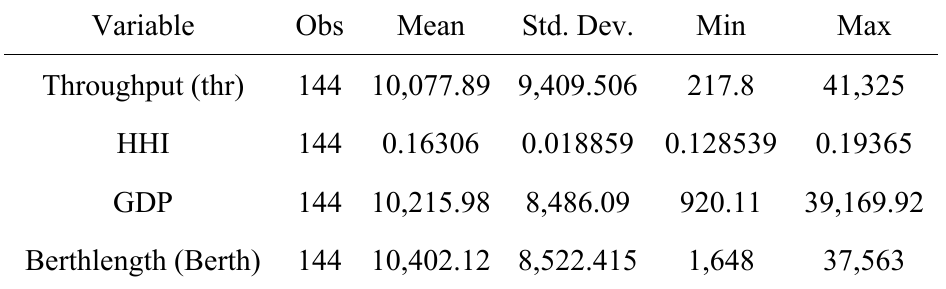
Table 3. Description Statistics of